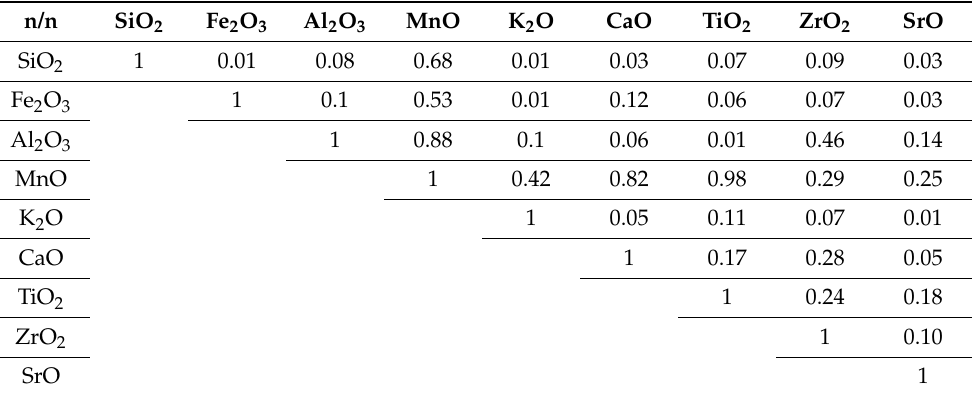
Table 5. Spearmen’s Correlation of Chemical Elements from the Study